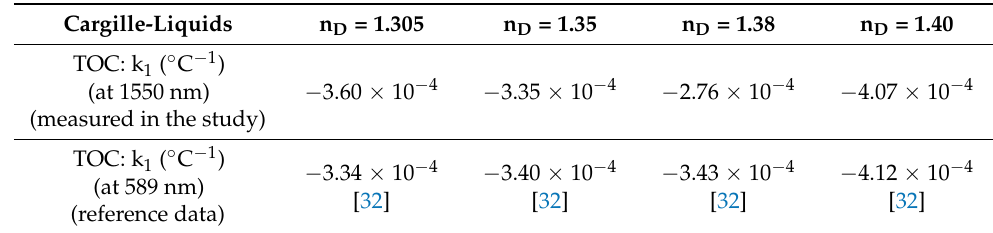
Figure 6. Measured interference spectra with different T values for the LLCFMZI filled with Cargille-liquids of n D = ( a ) 1.305, ( b ) 1.35, ( c ) 1.38, and ( d ) 1.40. ( e ) T-sensitivities of Δλ for different Cargille-liquids. ( f ) T-sensitivities of the experimental and theoretical values for different Cargille- liquids as fillers. Table 2. Comparisons of TOCs for different Cargille-liquids between the experimental results and that of the reference data.